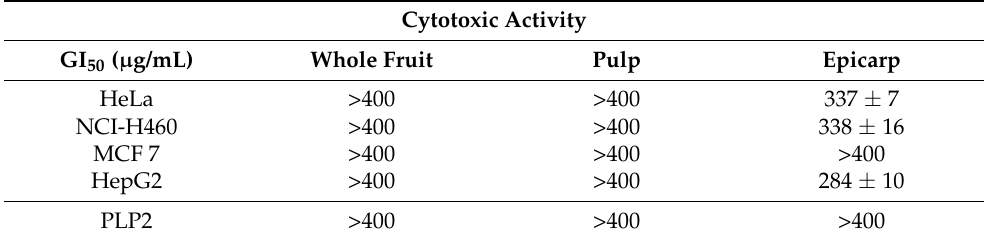
Table 8. Cytotoxic activity of S. melongena extracts (whole fruit, epicarp, and pulp) (mean ±